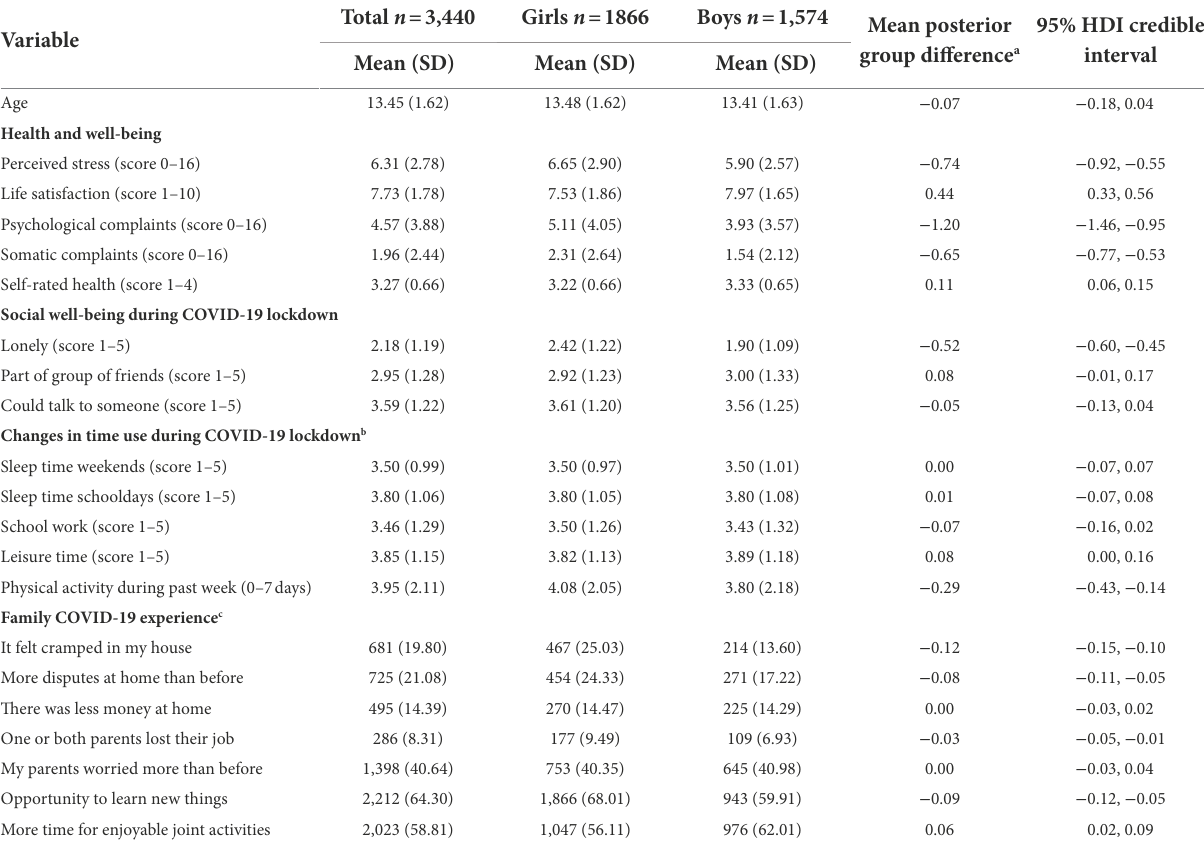
TABLE 1 Descriptive characteristics of the